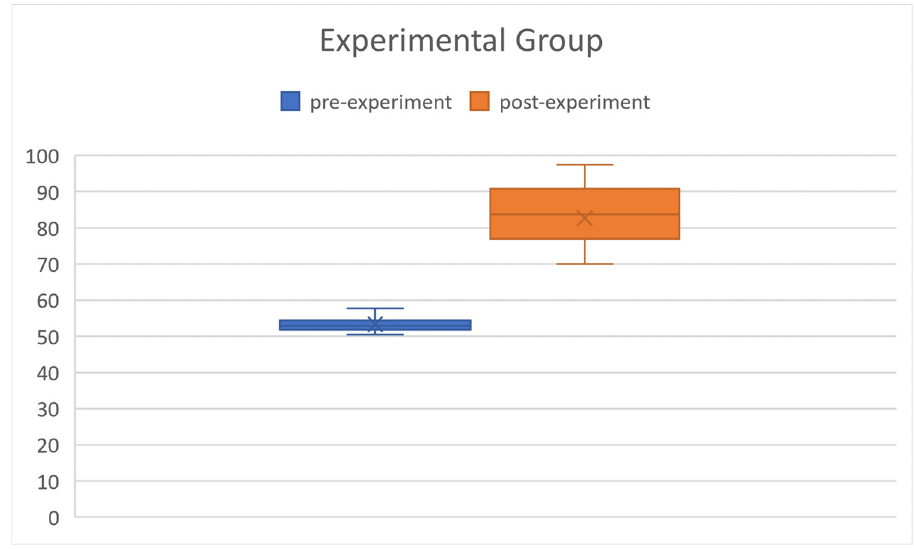
Figure 12. Pre ‐ experiment and post ‐ experiment data of the experimental group.